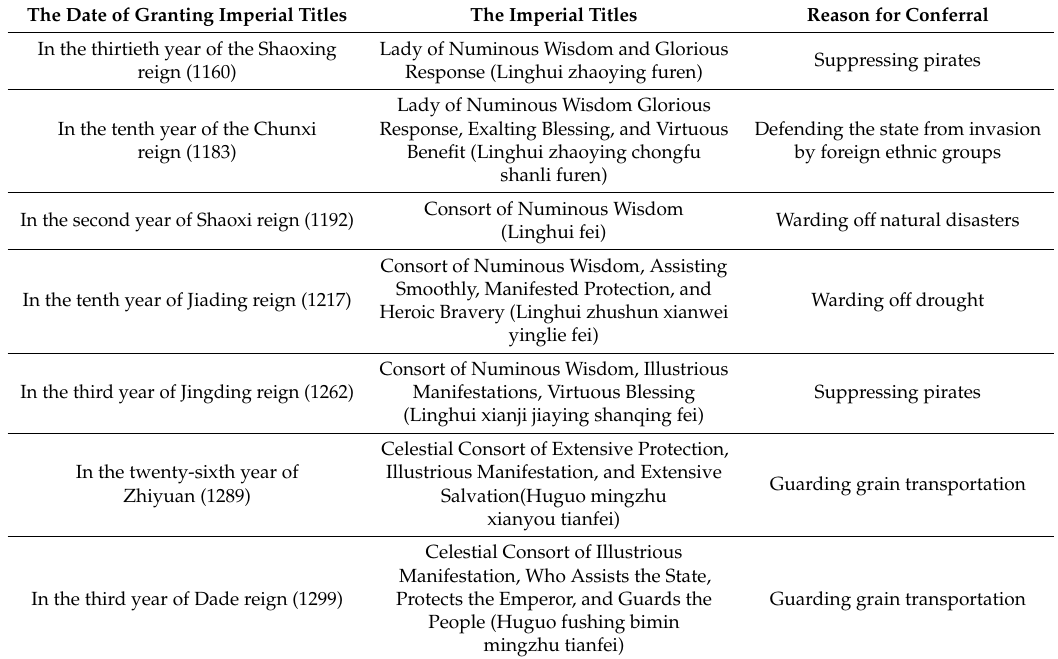
Figure 4. The Inscription of “A List of Imperial Titles Conferred by Di ff erent Dynasties.” Preserved in The Ancestral Hall of the Celestial Empress at Xianliang Port. Source: Provided by the Temple management board of Xianliang gang zuci. Table 2. A table includes thirteen honorific titles granted by emperors, ranging from Guangzong of Song dynasty (1189–1194) to Qianlong